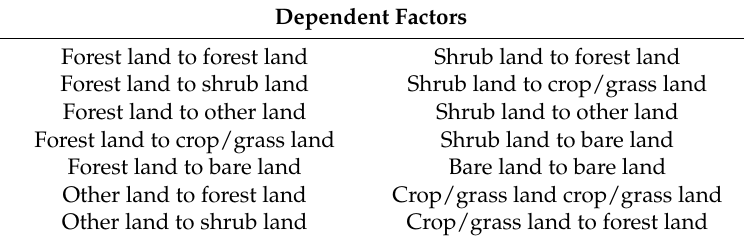
Table 3. List of dependent factors used in the multinomial logistic regression model.